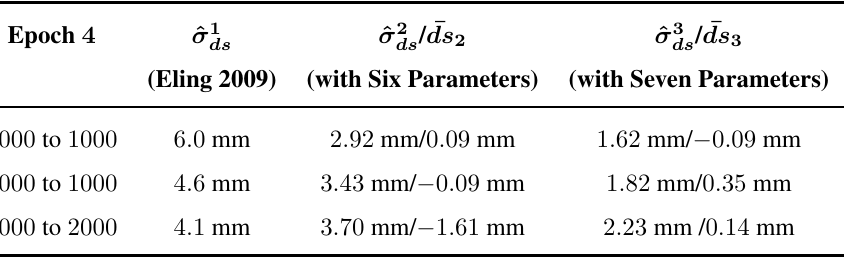
Table 4. The mean standard deviations and the mean values of the distance discrepancies of representative points between two scans in epoch 4 ( ˆ σ 1 standard deviations from [14] without fine registration, fine registration using six-parameter transformation and fine registration using seven-parameter transformation, respectively; ¯ ds and ¯ ds are the mean values from fine registration using the six- and the seven-parameter 3 transformation,